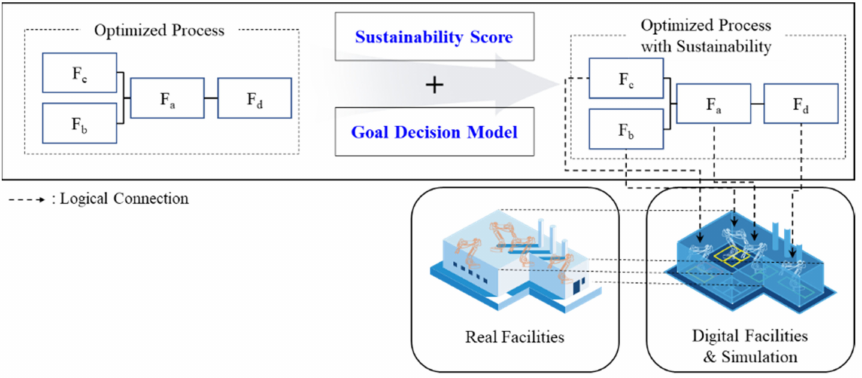
Figure 19. Sustainability assessment method in SSrMS.